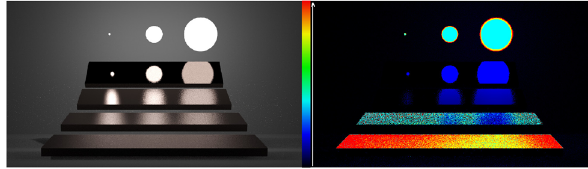
Fig. 4 A light transport covariance buffer. Left: the full color buffer. Right: the corresponding light transport covariance